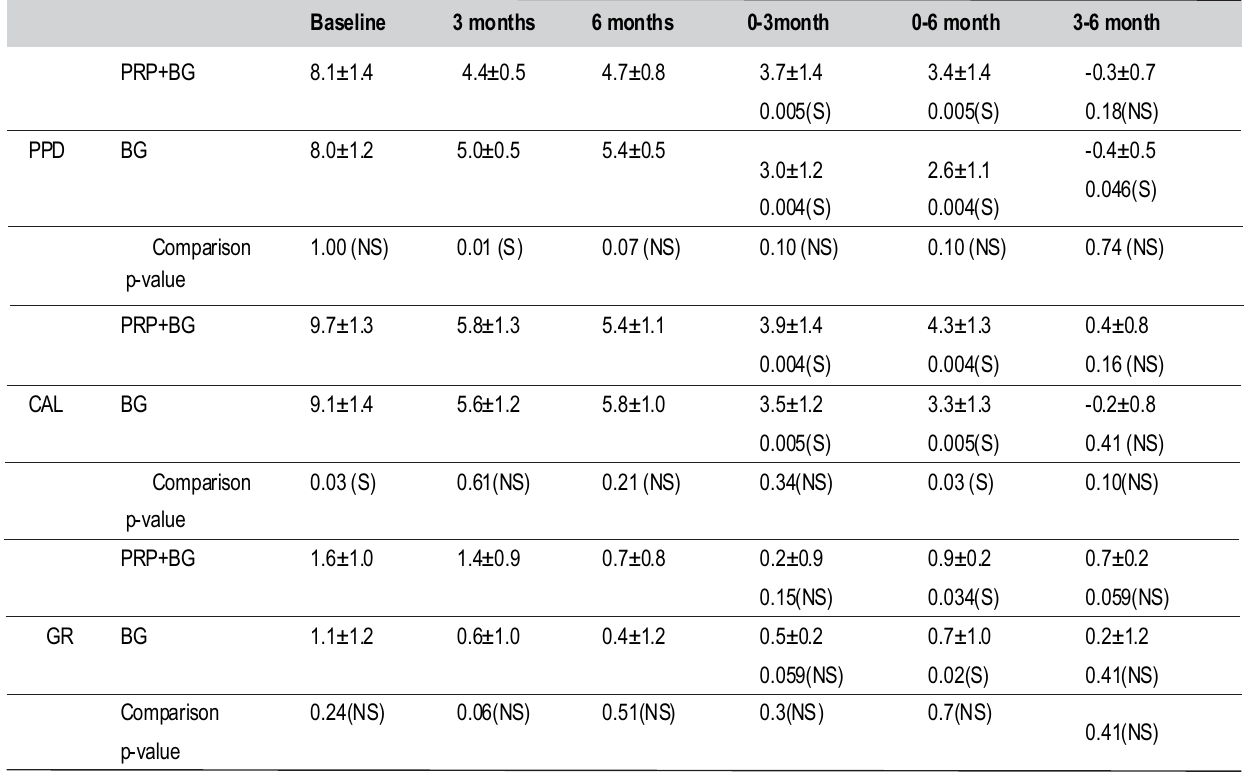
*Mean ± standard deviation; S, significant; NS, not significant; PRP, platelet-rich plasma; BG, bioactive glass Table 3 Changes in defect fill and in alveolar crest resorption in millimeters*